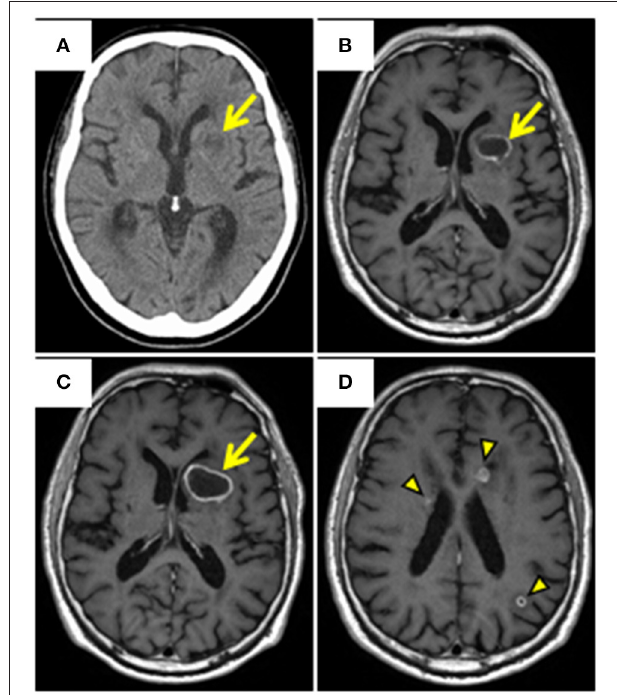
FIGURE 1 | Brain CT and MRI. (A) Axial plain CT reveals a round low-attenuation area with slightly high-attenuation rim in the left lenticular nucleus (arrow). (B) Axial gadolinium-enhanced T1-weighted MRI reveals ring enhancement in the area (arrow). (C, D) MRI following the initial treatment reveals enlargement of the existing abscess (arrow), and new ring enhancement (arrowheads) in the bilateral periventricular and subcortical areas. CT, Computed tomography; MRI, Magnetic resonance